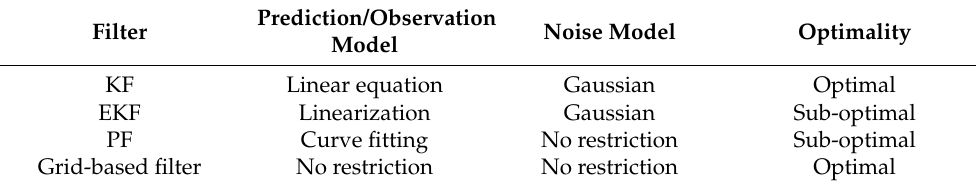
Table 1. Filter comparison according the model restrictions and optimality in phenological estimation. Prediction/Observation Filter Model KF Linear equation EKF Linearization Gaussian PF Curve fitting No restriction Grid-based filter No restriction No restriction